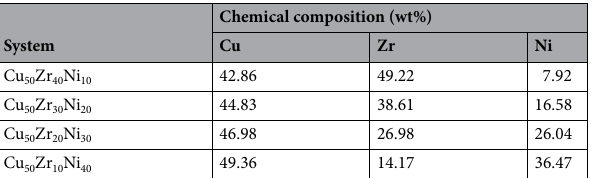
Table 1. Elemental analysis conducted by field-emission scanning electron microscope (FE-SEM)/energy dispersive X-ray spectroscopy (EDS) of the starting materials for as-hand mixed Cu 50 Zr 40 Ni 10 , Cu 50 Zr 30 Ni 20 ,